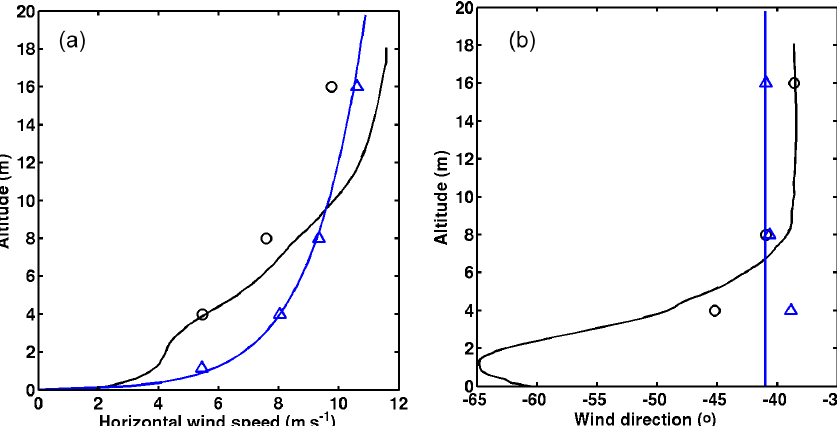
Figure 17. Mean vertical profiles in the MUST experiment: (a) | u | horizontal velocity; (b) atan (v/u) wind direction at the S (blue) and T (black) towers. The symbols (lines) are the Yee and Biltoft (2004) experimental measurements (MNH–IBM